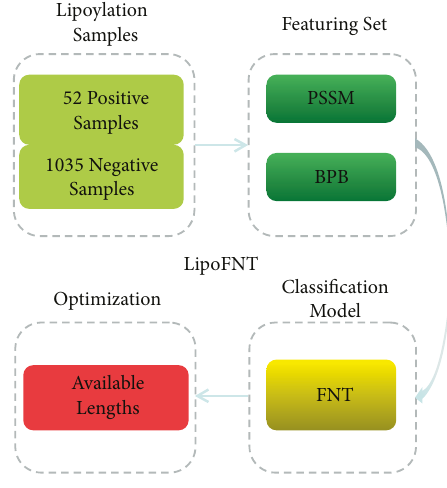
Figure 1: Outlines of